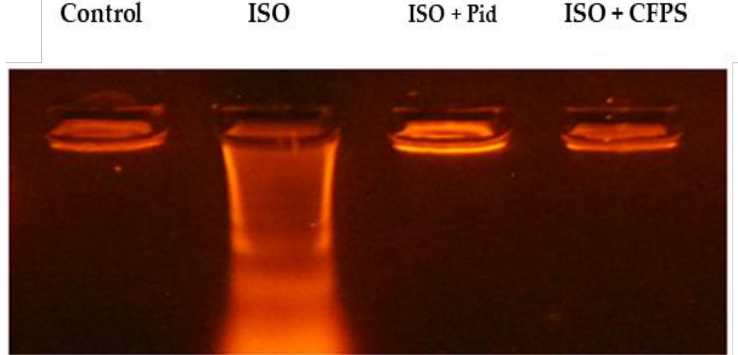
Figure 6. Gel electrophoresis DNA of all treated rats. Lane 1 (control): DNA isolated from the heart tissue of control group; lane 2 (ISO): DNA isolated from group treated with isoproterenol; lane 3 (ISO + Pid): DNA isolated from group precotreated with pidogrel; and lane 4 (ISO + CFPS): DNA isolated from group precotreated with CFPS.